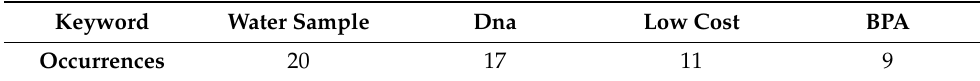
Table 8. Cluster 5 keywords and occurrences.